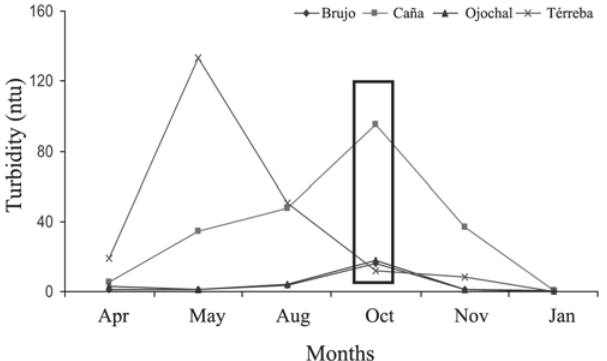
Fig. 7. Turbidity at the main River Térraba and the streams. The marked area is about October, when Térraba was less turbid than